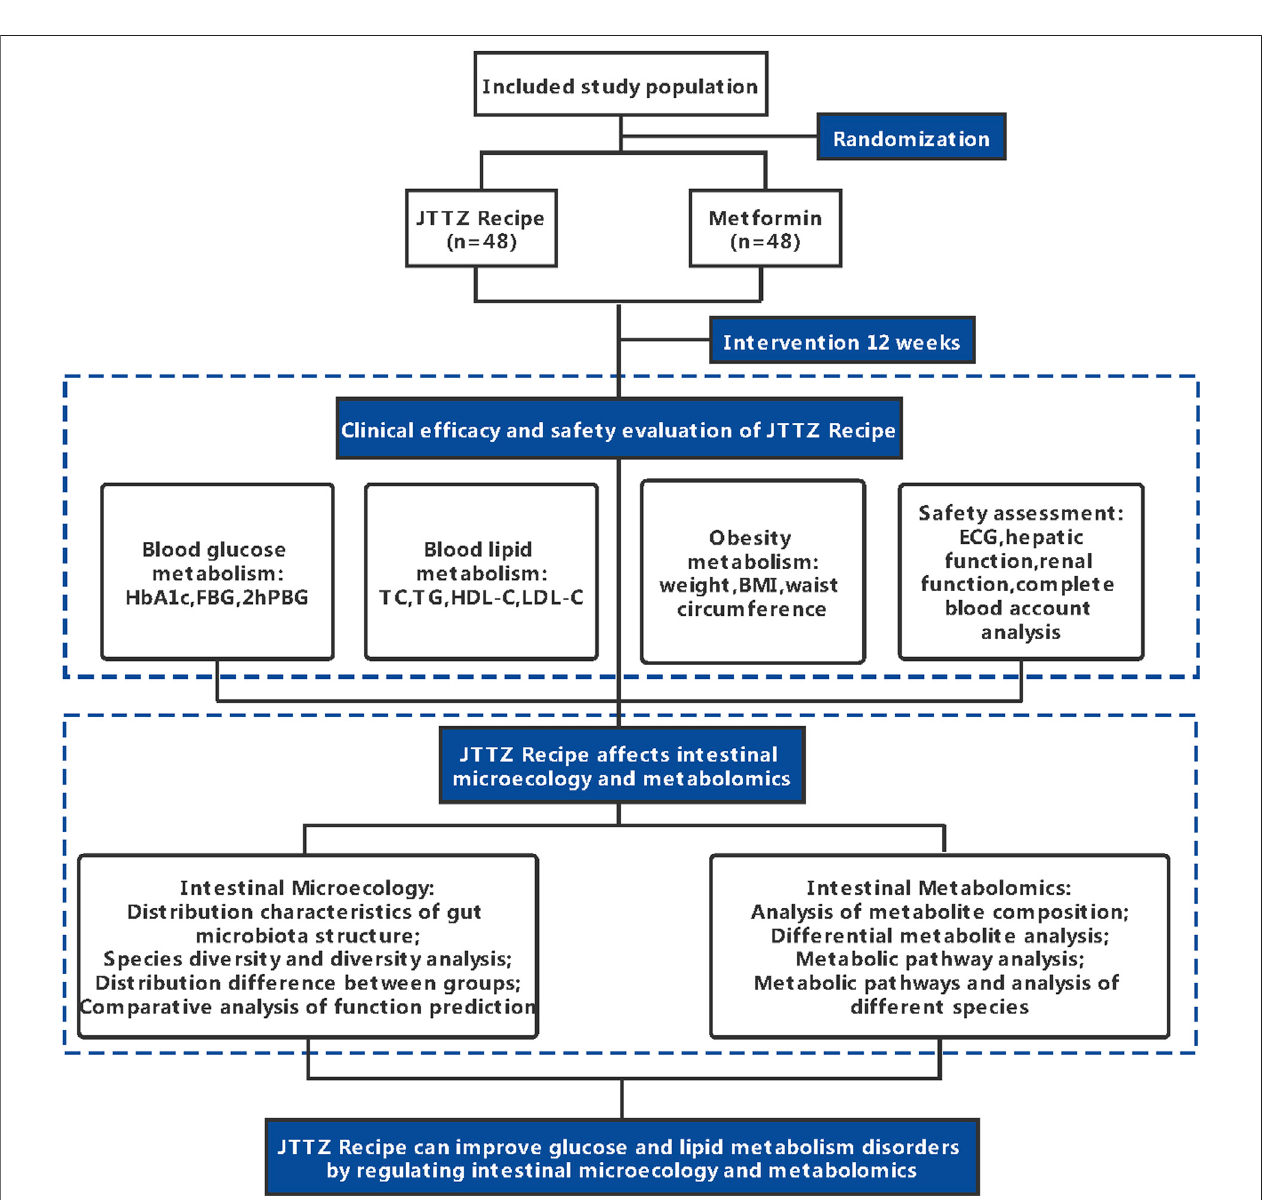
FIGURE 1 | Flow diagram of the study